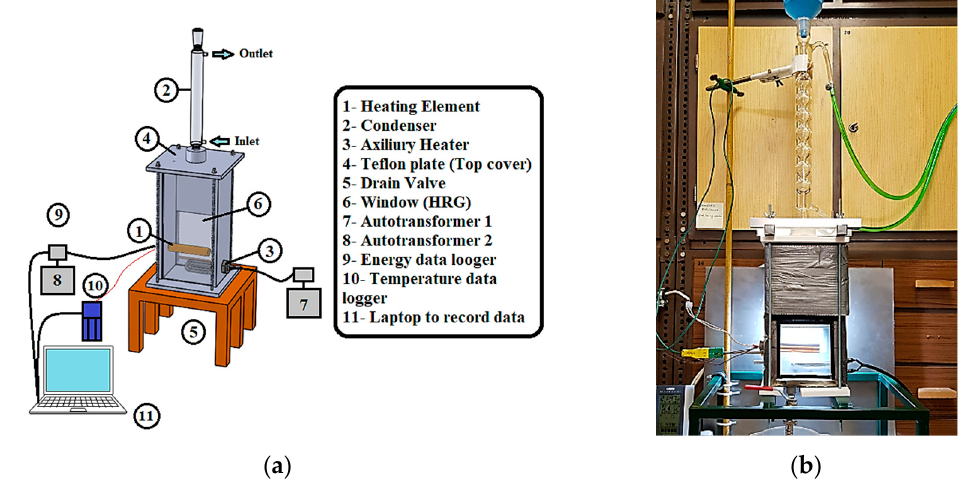
Figure 3. ( a ) Schema of the pool boiling apparatus, ( b ) real picture of the pool boiling apparatus.